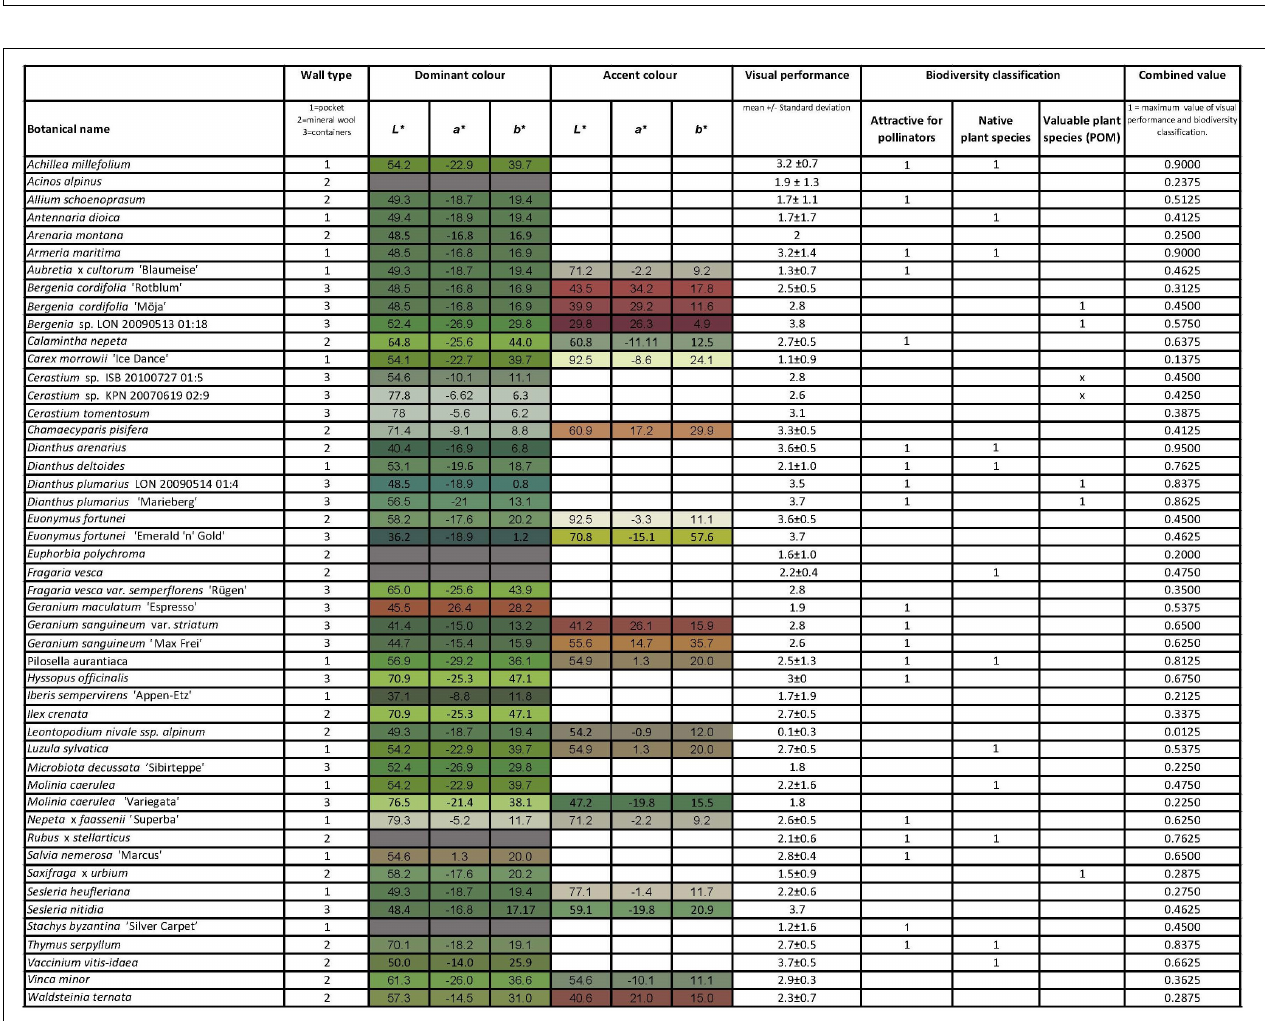
FIGURE 2 | Compilation of the species studied, and the species mean visual performance, biodiversity classification and the combined value. Plant species marked with grey hue indicates that no colour measurements have been performed. Number 1 in the Biodiversity classification columns indicated that the plant species: is attractive for pollinators; belongs to native plant species or is cultivated culturally valuable plant species (POM).